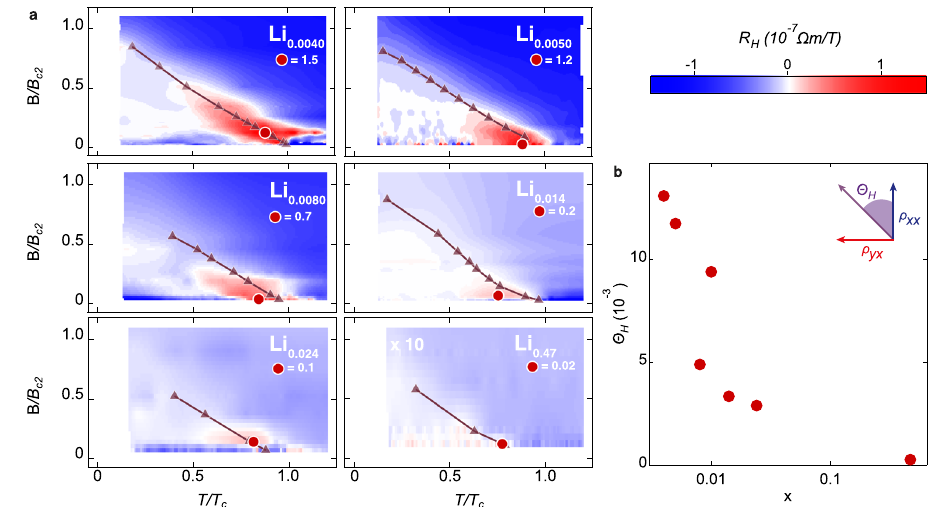
Fig. 3 | Mapping the vortex Hall effect at different doping levels. a Color map- pingoftheHallcoef fi cient R H ontheB- T phasediagramfordifferentdopinglevels. Horizontal and vertical axes are temperature normalized by T c and magnetic fi eld normalized by upper critical fi eld B c2 atzero temperature, respectively. The VHE is visible in the red regions with a sign change of R H . The areas of VHE are increasing